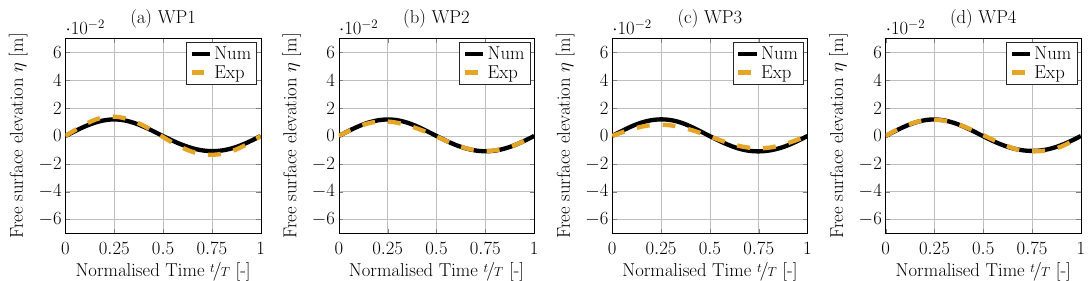
Figure 6. Phase-averaged free surface elevation, measured at wave probes WP1–WP4 ( a – d ), for wave RW1.